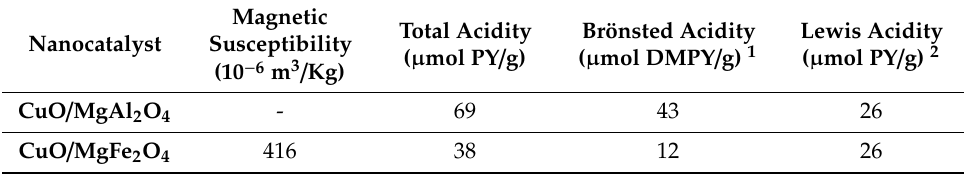
Table 2. Acidity and magnetic properties of CuO / MgAl 2 O 4 and CuO / MgFe 2 O 4 nanocatalysts.